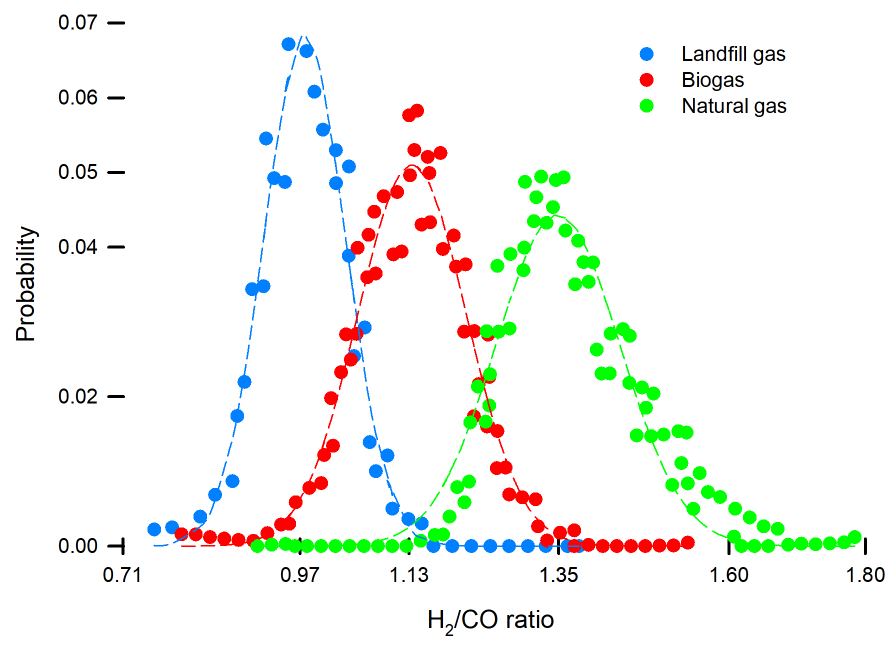
Figure 3. Three thousand Monte Carlo iterations calculating the distribution of the hydrogen/carbon monoxide molar ratio after the CPOX unit for the three feedstocks